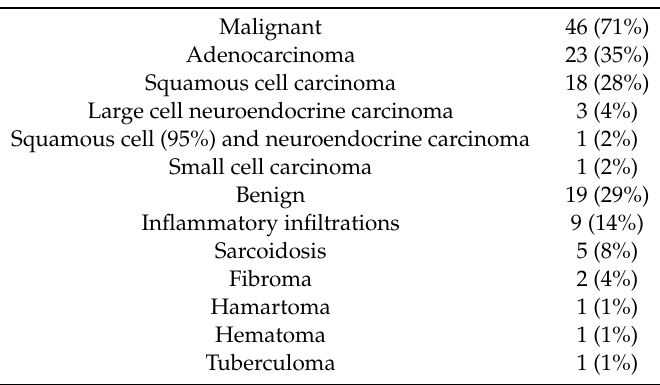
Table 2. Nodules diagnoses and